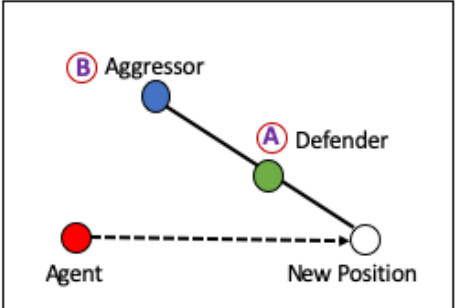
Figure 6. Rules for playing the Defender Aggressor